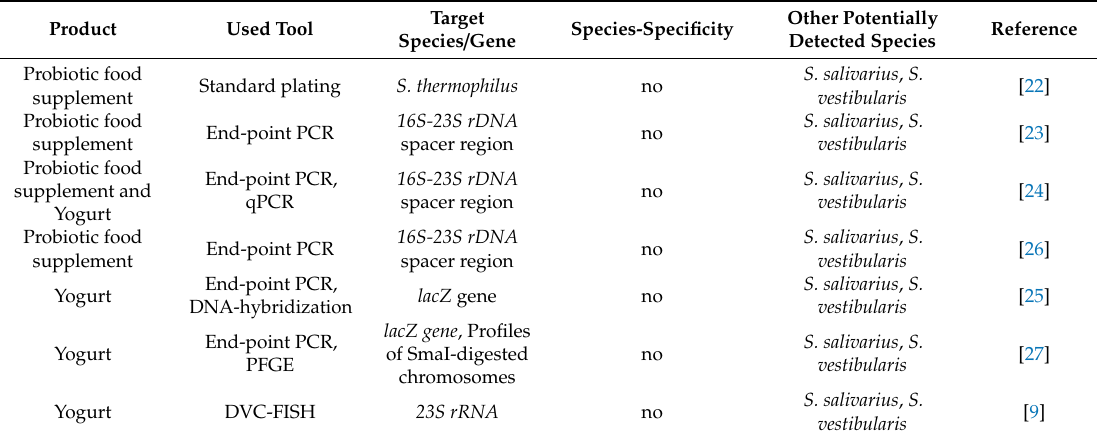
Table 2. Overview of tools used in interventional studies for viability assessment of S.